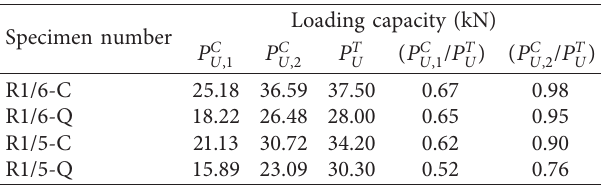
Table 4: Theoretical and experimental results of load bearing